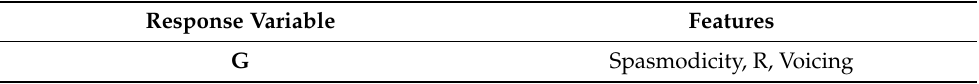
Table 6. Most relevant features obtained by averaging and normalizing LIME predictors’ weights for the G index in the second AI